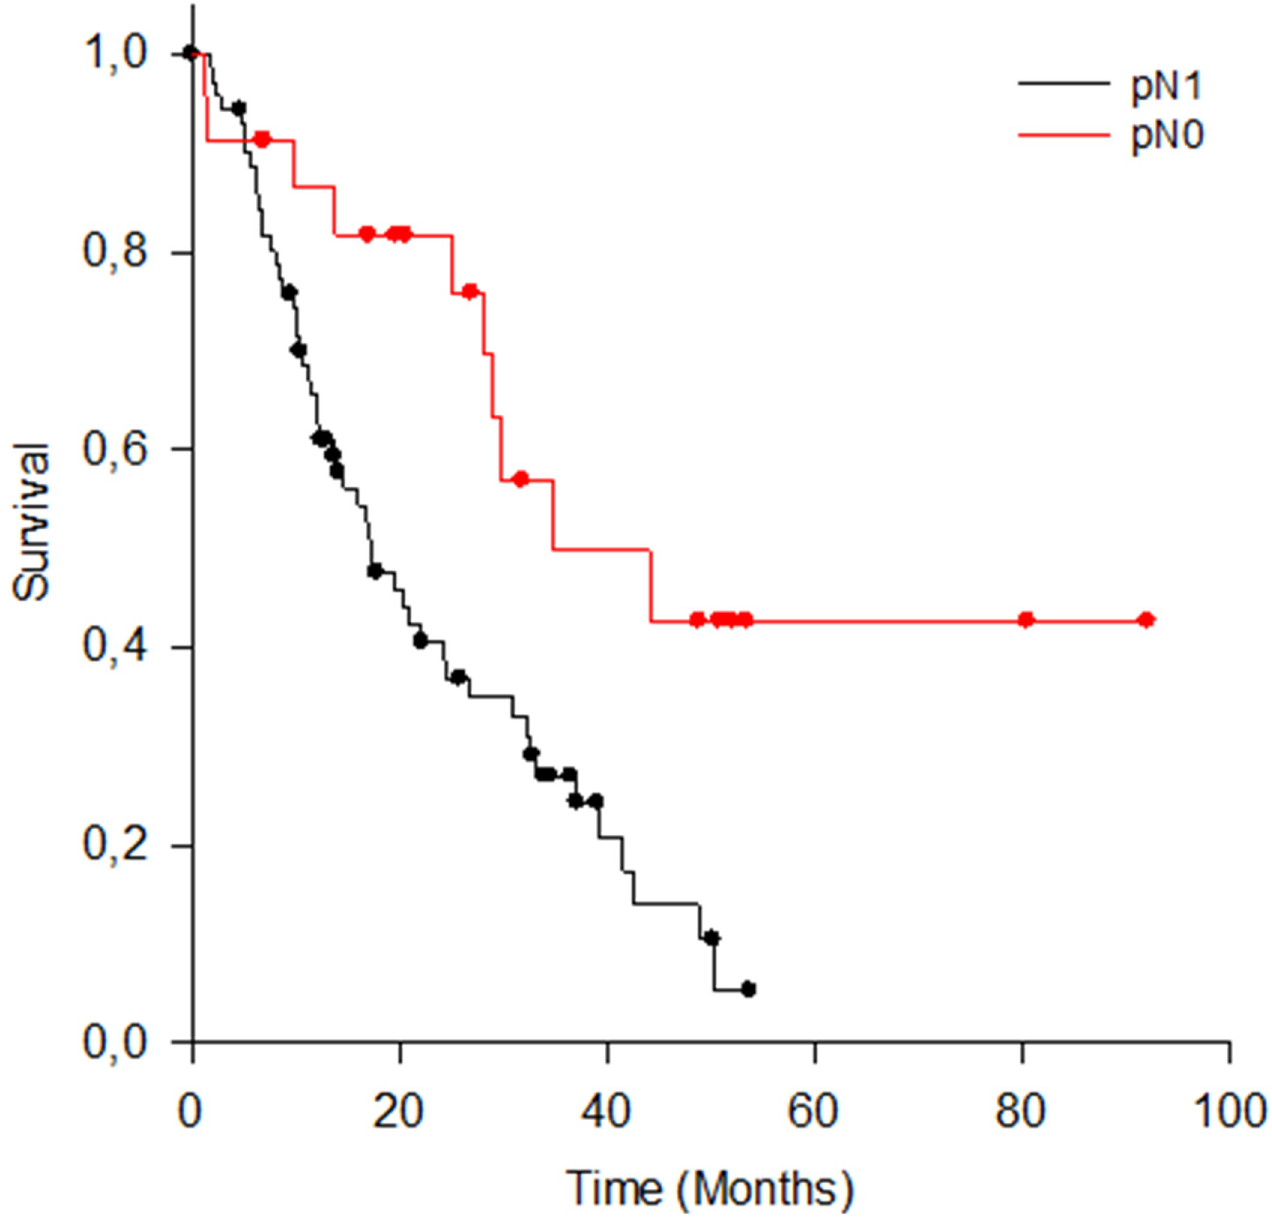
Fig 5. OS fu¨r pN0 and pN1